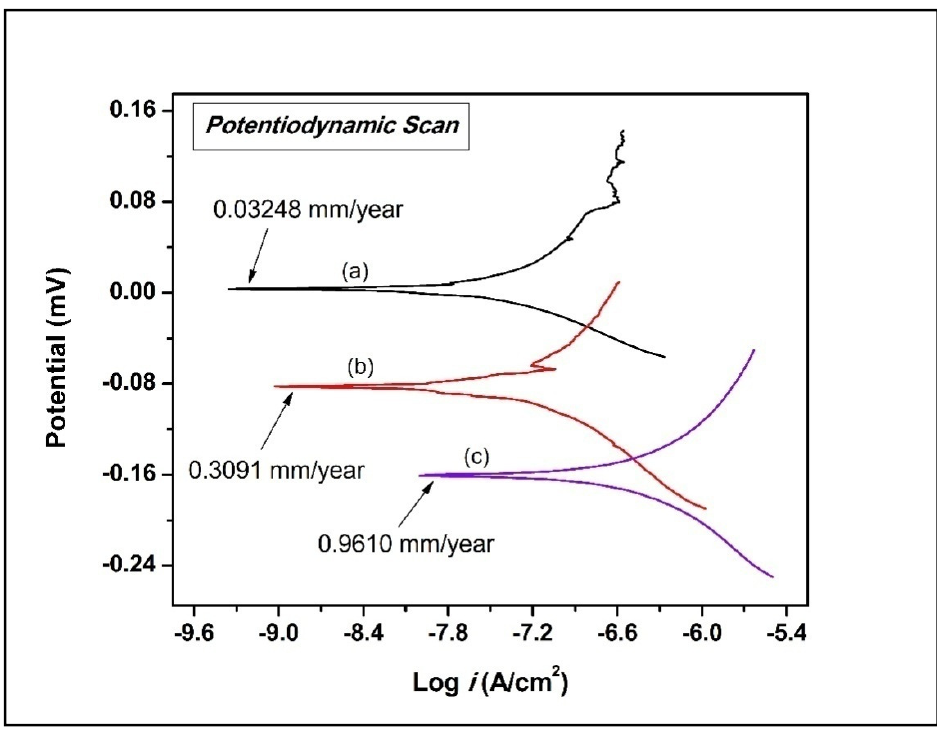
Figure 8. Combined polarization curves of samples ( a ) treated in MWCNTs, ( b ) treated in plain dielectric, ( c ) substrate.